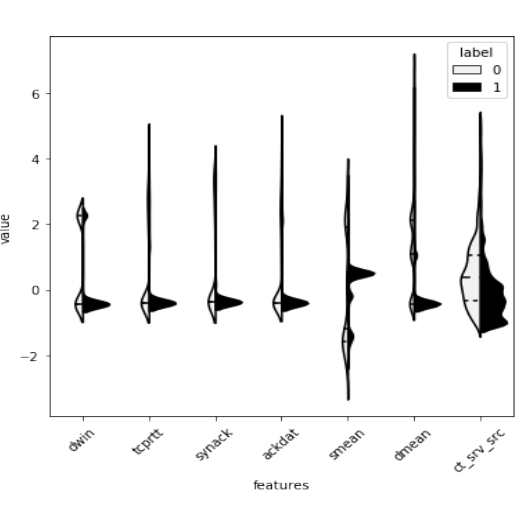
Fig 4. Violin plots for some similar features in the